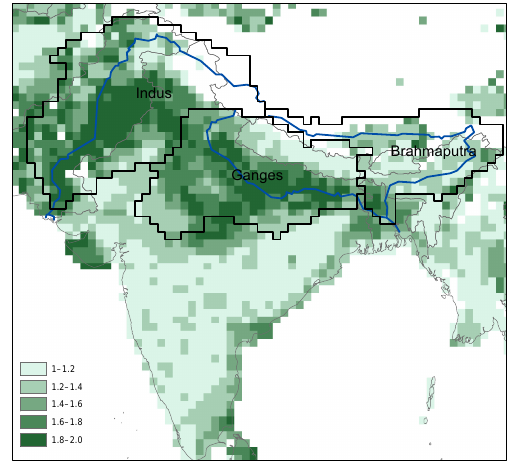
Figure 1. Cropping intensity in South Asia (land use data sets de- rived for this study based on MIRCA2000. Average cropping inten- sity is defined here as the total annual harvested area (kharif and rabi) divided by the maximum cropped area of the two cropping seasons. Study-basin delineations are indicated in